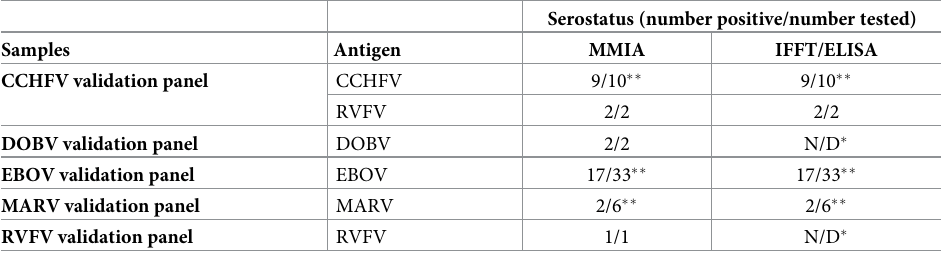
Table 1. Comparison between the MMIA and the commercial IIFT/ELISA or in-house ELISA results using the serum samples from the validation panels. � Only validation panels where all samples did not test 100%